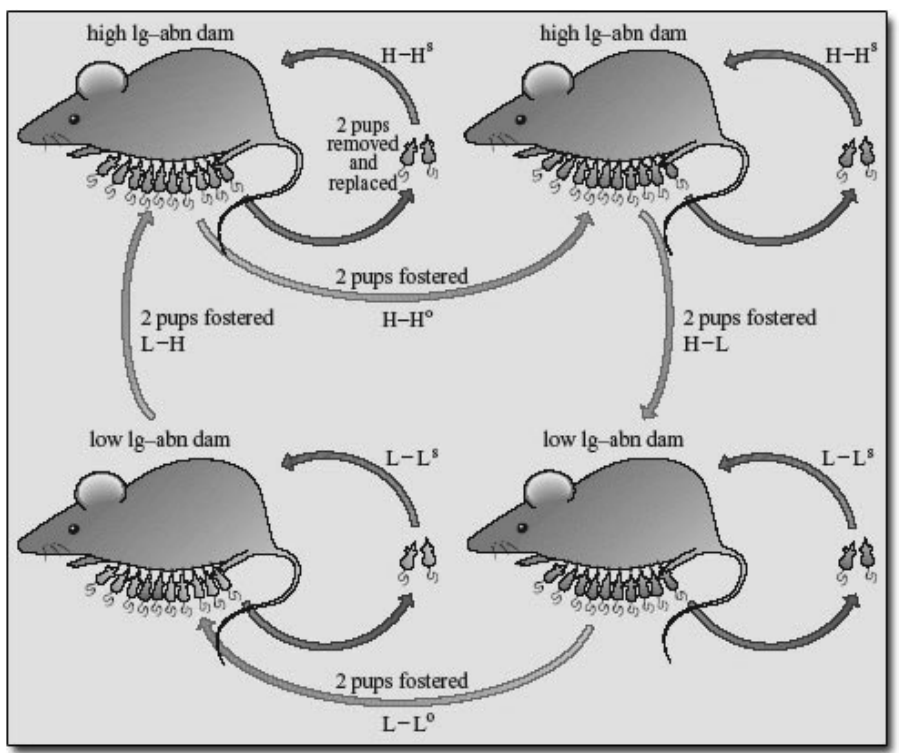
Figura 1. Adoção cruzada entre parideiras com altas e baixas taxas de LG-ABN. Recuperado em